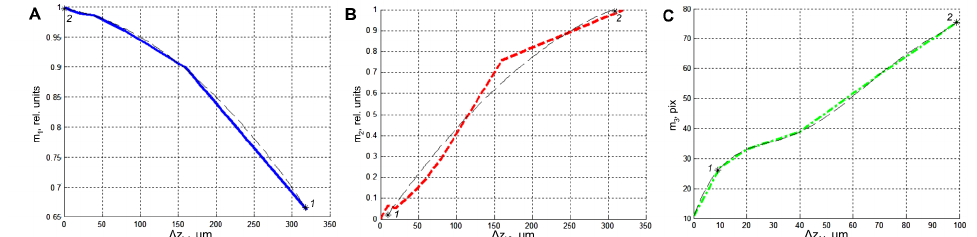
Figure 8. Metrics sensitivity to the optical elements misplacement: ( A ) primary mirror vertical segment; ( B ) primary mirror tilted segment; ( C ) secondary